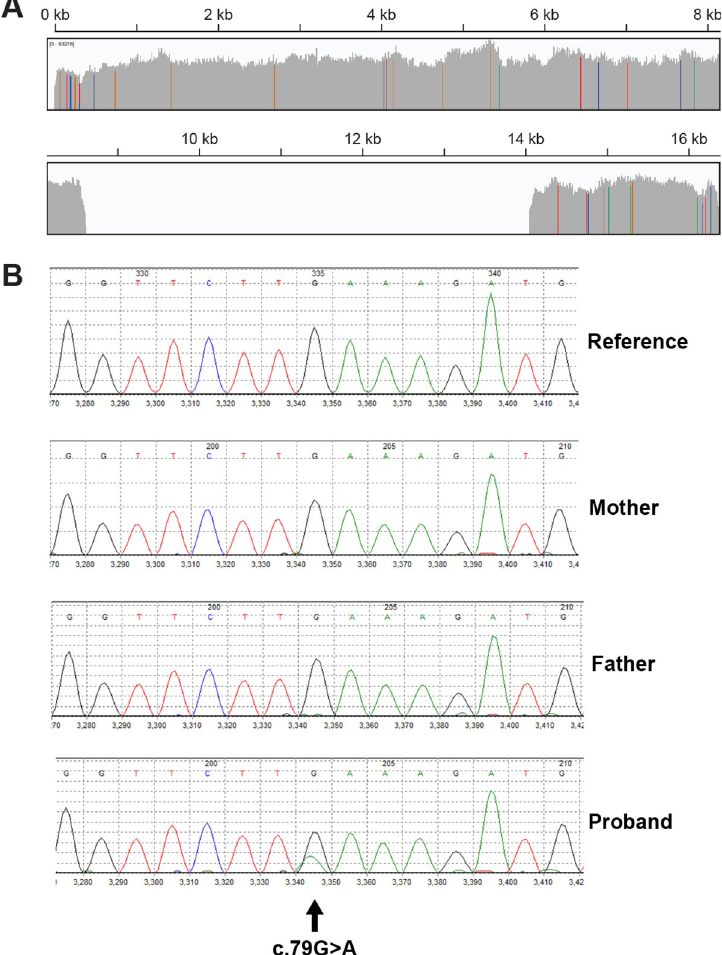
Fig 3. Mitochondrial disease proband with complex disease manifestations was discovered to harbor a SLSMD and a de nov o dominant SSBP1 novel variant of uncertain significance. A. mtDNA deletion (m.8629_14068del5440) was detected in proband blood by NGS. The vertical gray bars represent absolute coverage of next generation sequencing reads for each base position of the reference mitochondrial genome. Green, blue, red and orange vertical bars indicate base pair differences from the reference (rCRS). The drop in coverage represents the large scale mitochondrial DNA deletion. Base positions are represented across the top of the figure. The depth of coverage shown in this figure is not reflective of total percent of deleted DNA in the starting population. B. SSBP1 de novo c.79G > A variant was identified by exome